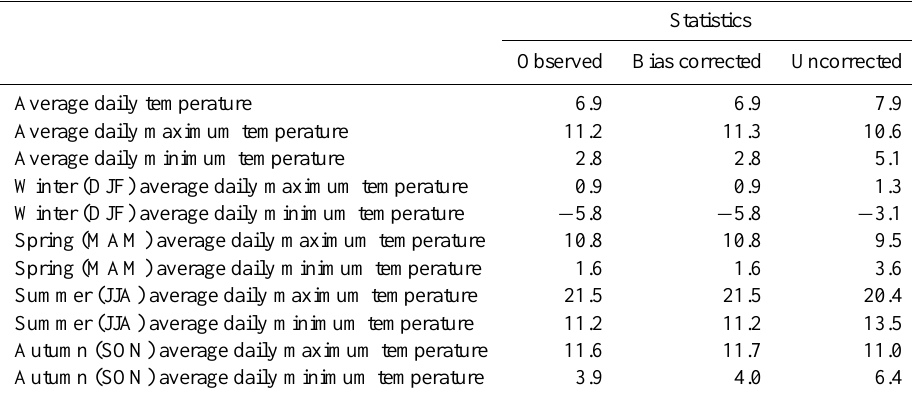
Fig. 5. Ratio between HIRHAM5-ECHAM5 simulations and observations of seasonal 5-days maximum precipitation for the control period 1961–1990. First row, uncorrected seasonal precipitation; second row, bias corrected seasonal precipitation. Table 2. Summary statistics of (2m) temperature ( ◦ C) for the control period